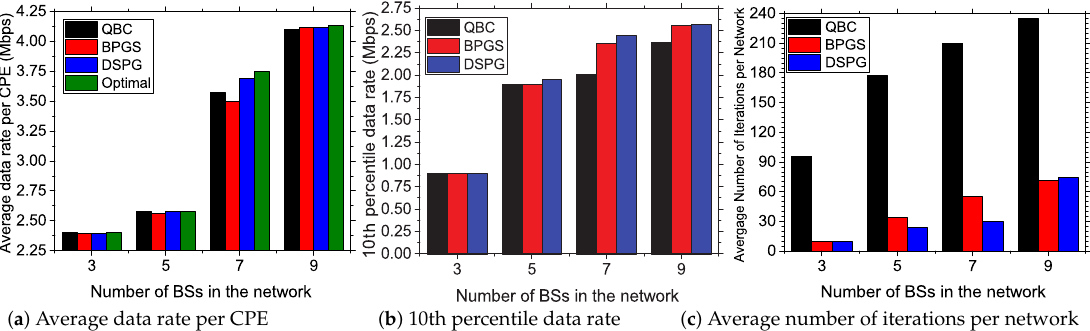
Figure 8. Impact of the number of BSs in the network on the performance of the studied resource allocation